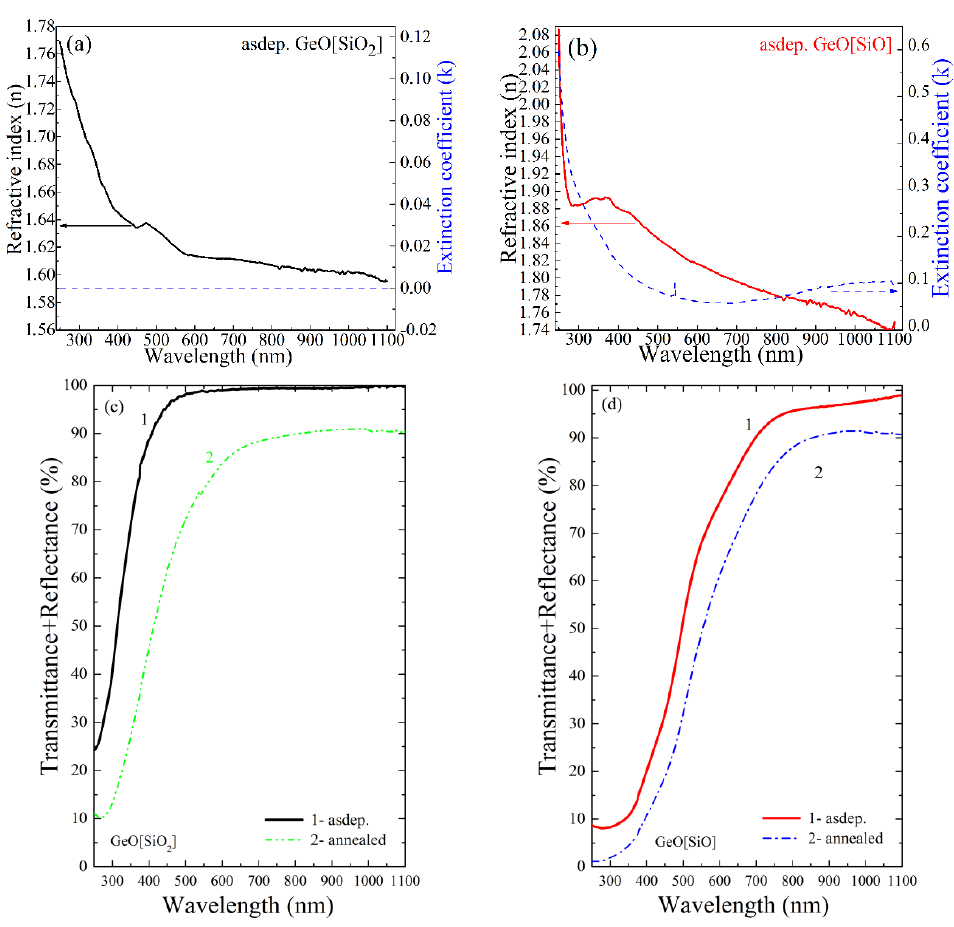
Figure 4. ( a , b ) Refractive index (its real part n) and extinction coefficient (imaginary part of refractive index k) of the as-deposited thick GeO[SiO 2 ] and GeO[SiO] films, respectively. ( c , d ) The sum of the transmission and reflection spectra of the as-deposited and annealed thick GeO[SiO 2 ] and GeO[SiO] films on quartz substrate, respectively. Separate transmission and reflectance spectra are shown in Figure S3 in Supplementary Materials. Figure S3 in Supplementary